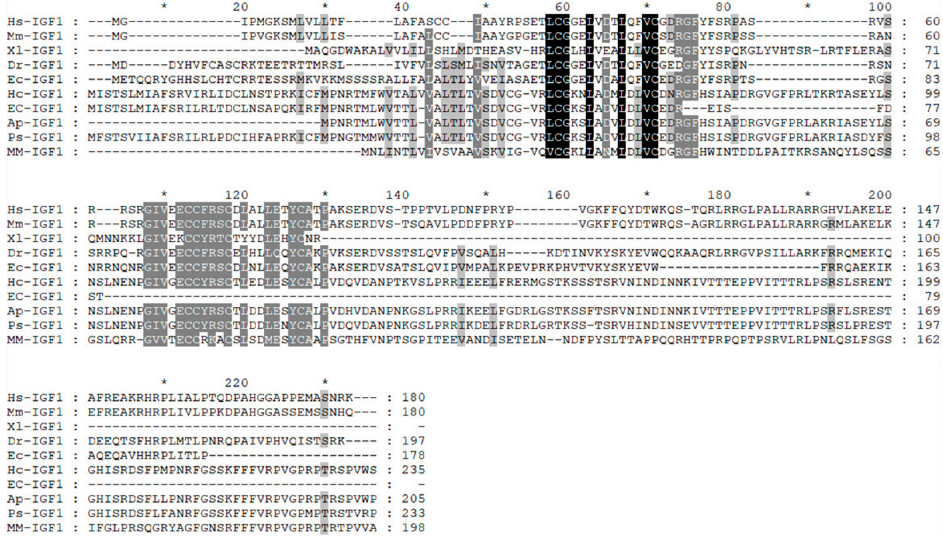
Figure 3. Sequence comparison of homology of IGF1 with other species with H. cumingii. Other species NCBI accession numbers: Homo sapiens (Hs): NP_000609.1; Mus musculus (Mm):